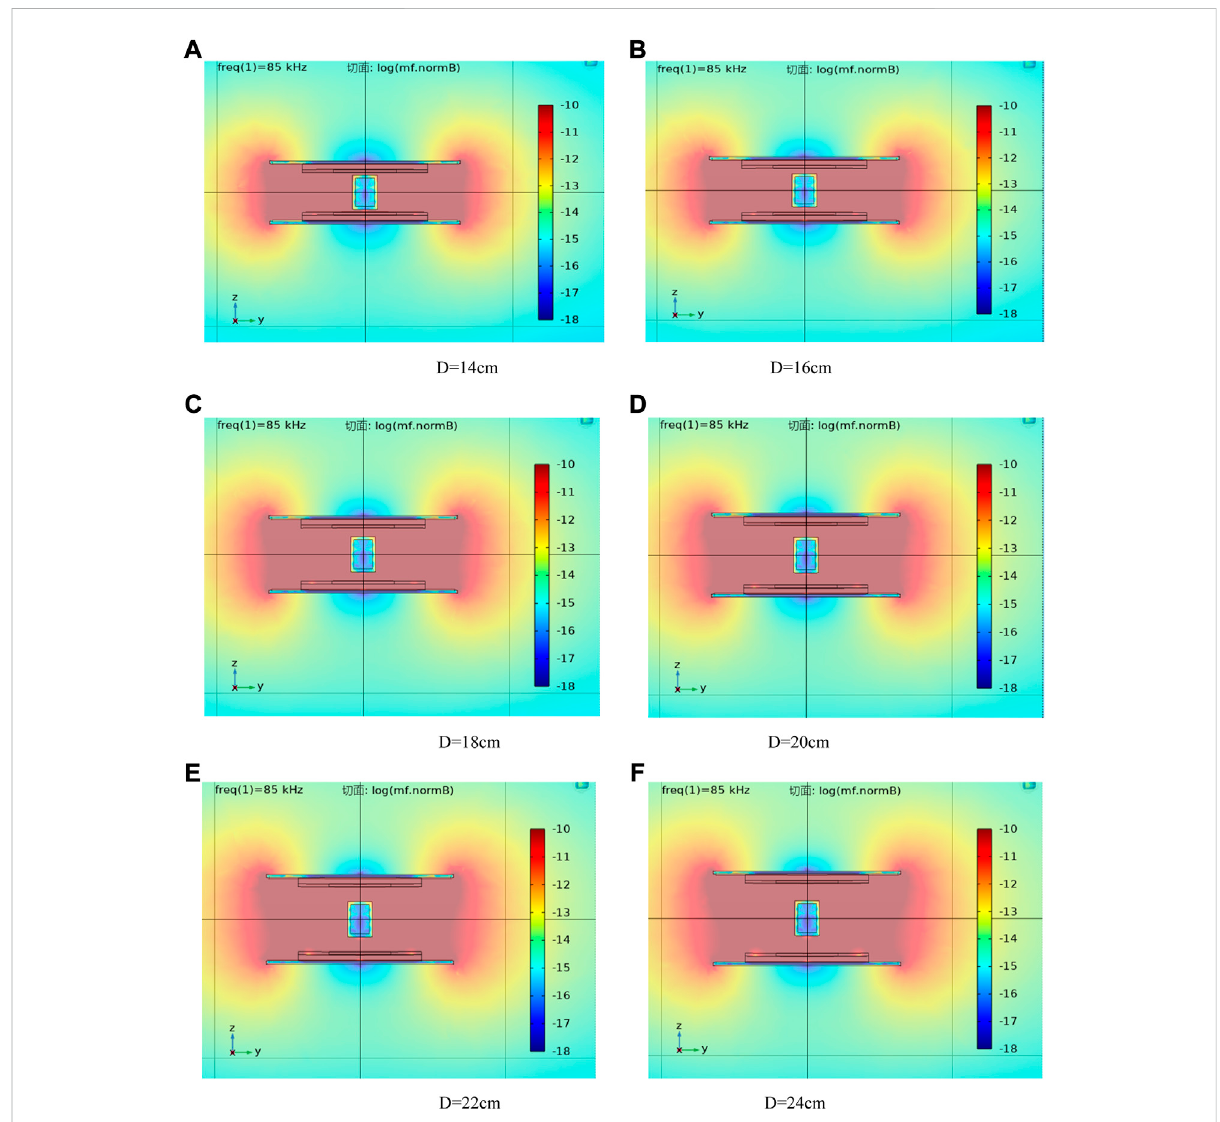
FIGURE 7 Magnetic fl ux density when the transmission distance of the coupler changes. (A) D = 14 cm. (B) D = 16 cm. (C) D = 18 cm. (D) D = 20 cm. (E) D = 22 cm. (F) D = 24